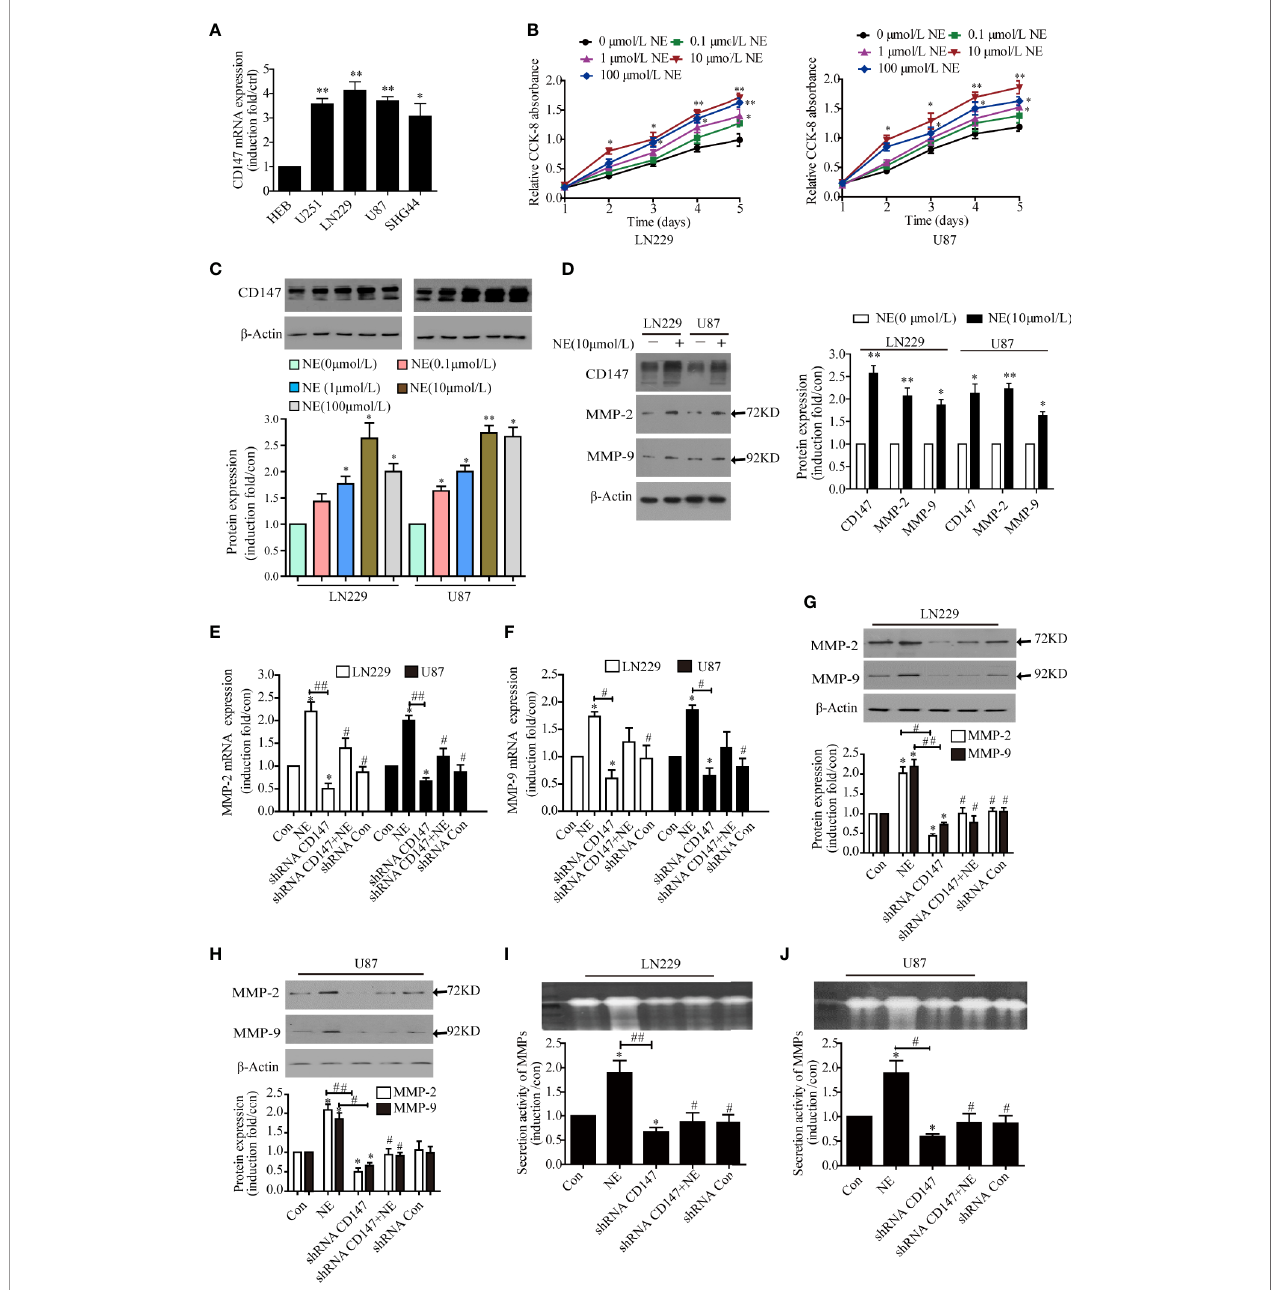
FIGURE 2 | CD147 Knockdown Reduced the Expression and Secretion of MMP-2 and MMP-9 Induced by norepinephrine (NE) in glioma Cells. (A) Detect the relative expression of CD147 in human glioma cell lines including HEB, U251, LN229, U87, and SHG44 by PCR. (B) Two glioma cells were incubated with different concentrations of NE for 1, 2, 3, 4, and 5 day. CCK-8 assay demonstrated that NE promoted the proliferation of glioma cells in a concentration-dependent and time- dependent manner. (C) NE increased expression of CD147 in a concentration-dependent manner. (D) The expression of CD147, MMP-2, and MMP-9 proteins was detected by western blotting. NE promoted the expression of CD147, MMP-2, and MMP-9. (E, F) qPCR con fi rmed that NE promoted the expression of MMP-2 and MMP-9, which were inhibited by CD147 knockdown. (G, H) Western blotting analysis showed that the expression of MMP-2 and MMP-9 protein in LN229 cells and U87 cells were decreased after transfection with shRNA-CD147. (I, J) Gelatinase assay showed that NE promoted matrix metalloproteinases (MMPs) secretion in two glioma cells, which was inhibited by CD147 knockdown. shRNA-Con was the negative control; data are expressed as the mean ± SD. *P < 0.05. **P < 0.01 vs Con (0 m mol/L NE). # P < 0.05. ## P < 0.01 vs 10 m mol/L